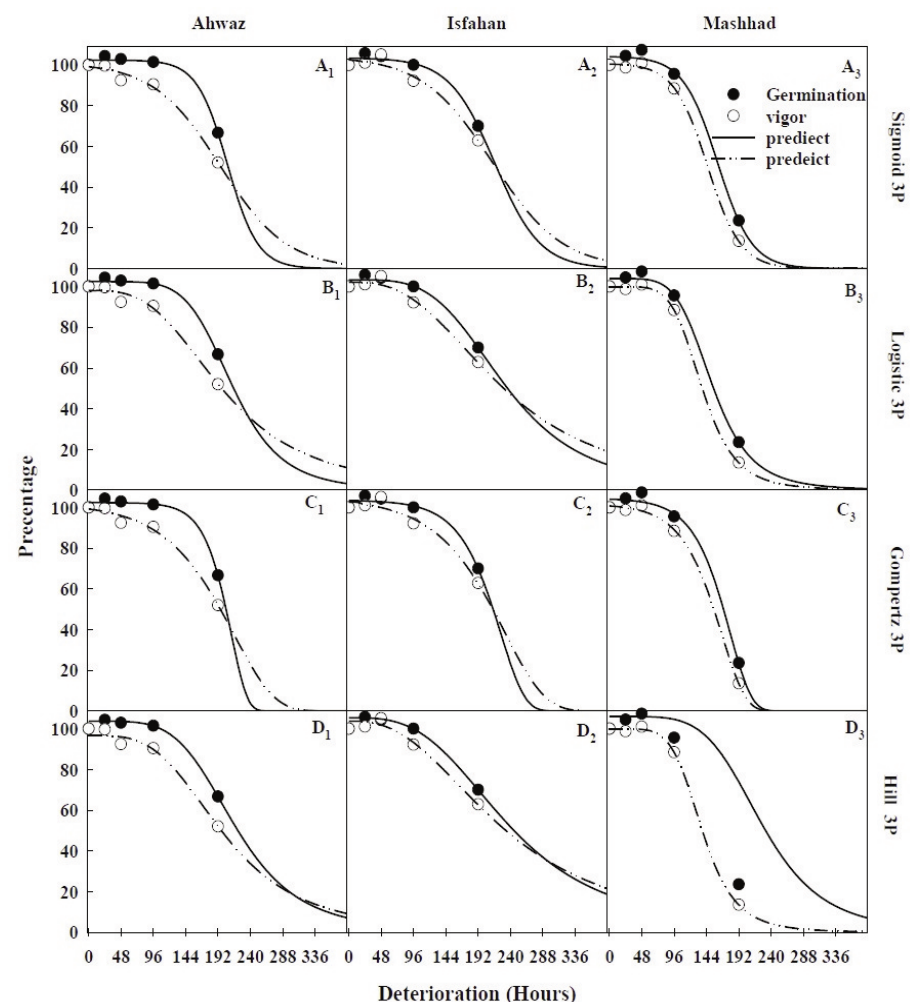
Fig. 4 - Model fit function 3 parameter of process deterioration germination and vigor ecotypes okra ( Abelmoschus esculentus L.). Points are the percentage of improvements in seed properties compared with control treatment (no aged seeds ) (● germina- tion percentage, ○ seedling vigor) and lines are predicted